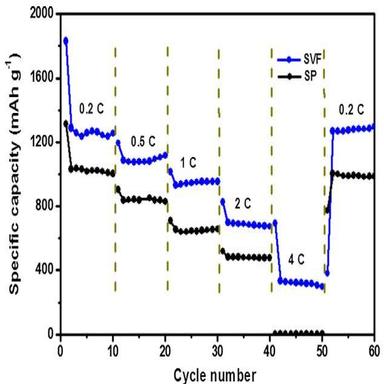
Rate performances of SVF and SP composites.